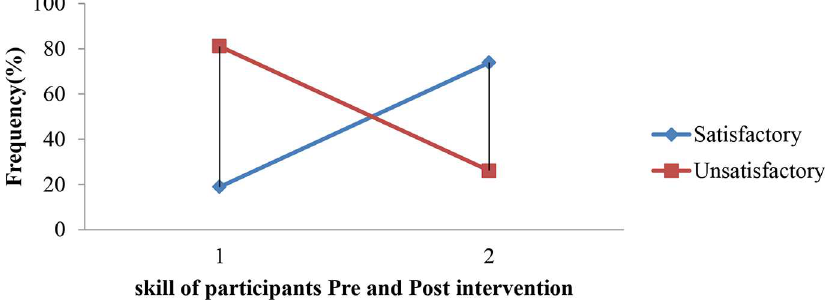
Fig 2. Pre- and post- interventions skill level of respondents in HawassaHealth Sciences College, 2015.